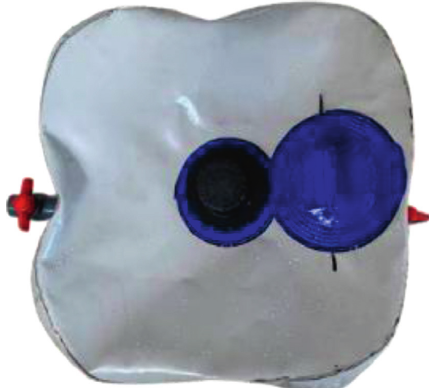
Figure 3: Model test water bladder.